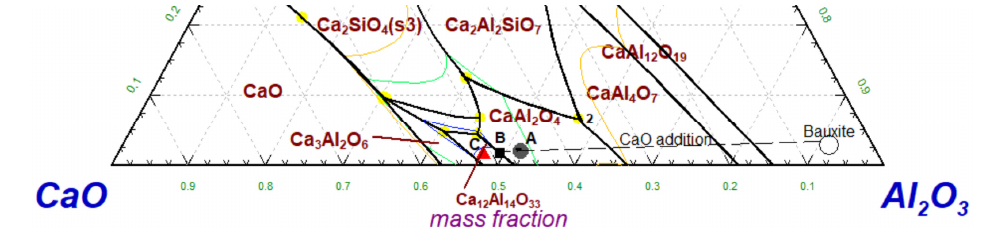
Figure 3. Section of the ternary phase diagram of CaO-Al 2 O 3 -SiO 2 calculated with FactSage. The figure presents the composition of feedstock bauxite (excluding Fe and minor elements), and the point A corresponds to S-CB-L1, point B to S-CB-L2 and point C to S-CB-L3